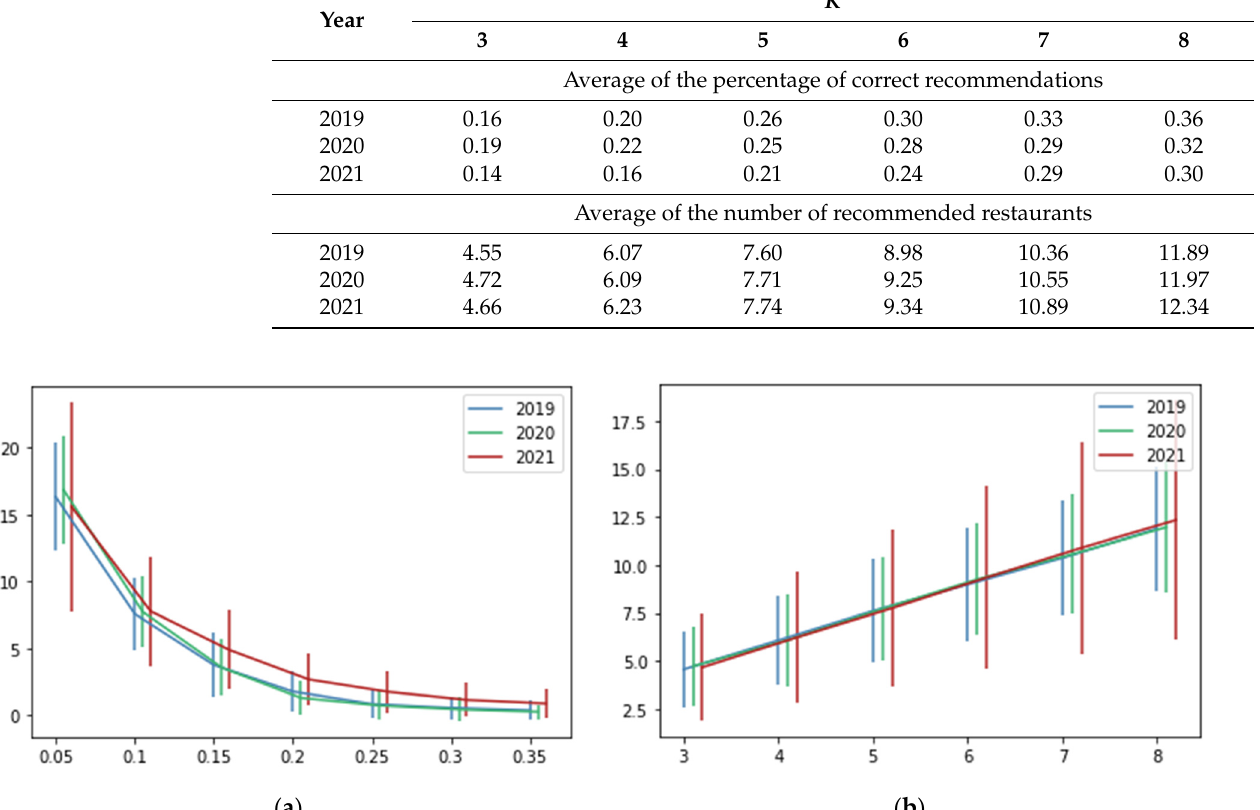
Figure 8. The average number of recommended restaurants ( y -axis) according to the values of the parameters ( x -axis). Vertical lines represent the standard deviation. ( a ) Testing different values for pmin , k = 5. ( b ) Testing different values for k , pmin = 0.1. Table 4. Results of our proposed recommendation system according to the value of the parameter pmin .